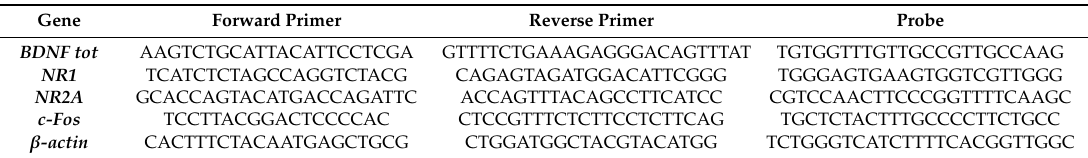
Table 1. Sequences of forward and reverse primers and probes used in real-time PCR analyses and purchased from Eurofins